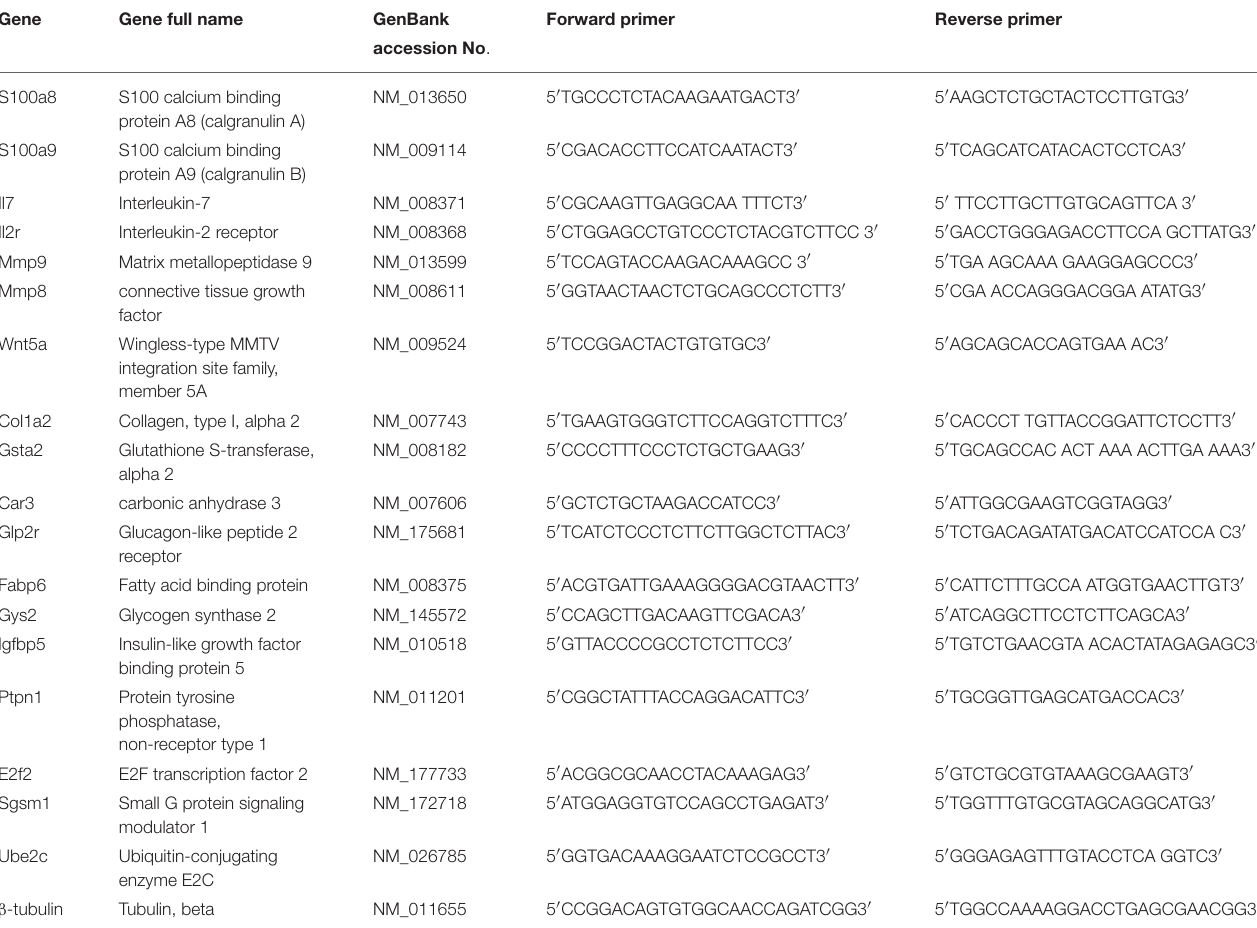
TABLE 1 | Sequence of primer used in real time PCR